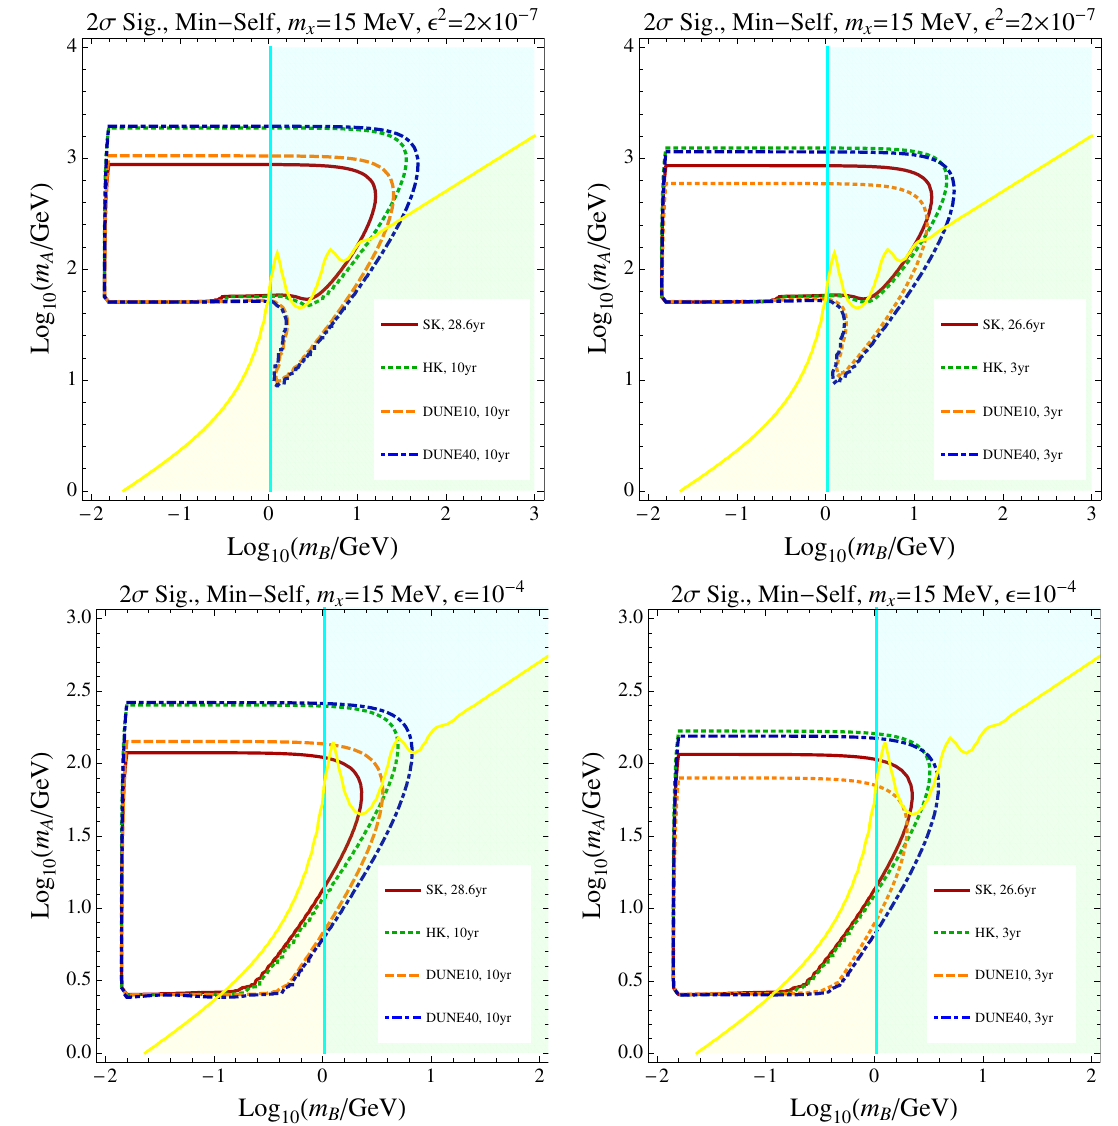
Figure 5 . 2 (cid:27) signi(cid:12)cance assuming 5 years of construction and 10 years of physics running of DUNE/HK (left), and 10 years of construction and 3 years of physics running of DUNE/HK (right) for (cid:15) 2 = 2 10 (cid:0) 7 ( (cid:15) = 10 (cid:0) 4 ) in the top (bottom) panel. All curves assume Min (cid:2)